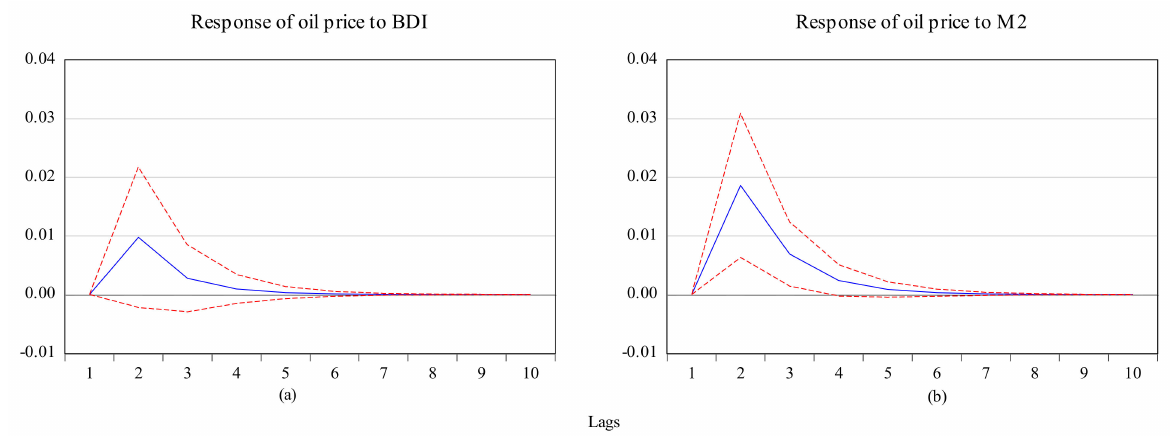
Figure 2. Identification of oil commodity attribute and financial attribute. Notes: ( a ) refers to the identification of oil’s commercial attribute, and ( b ) is the identification of oil’s financial